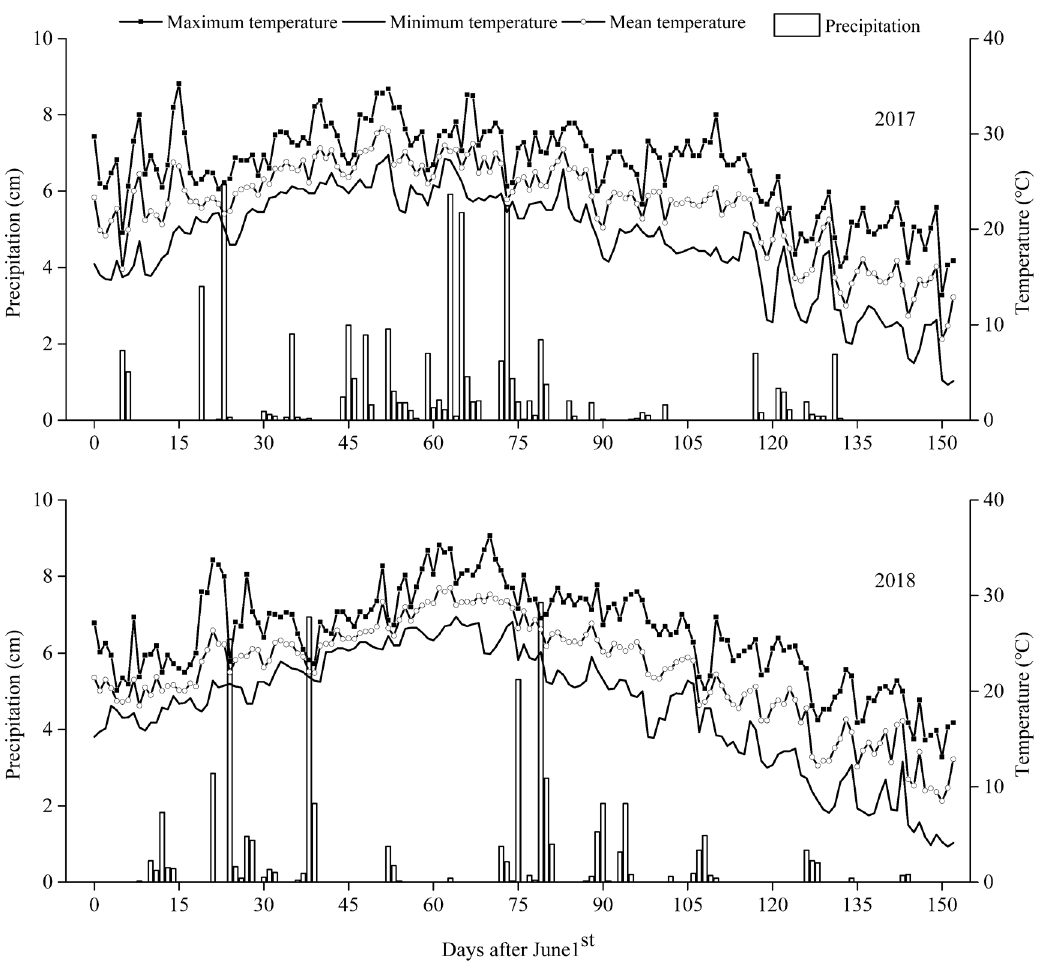
Figure 3. Precipitation (cm), maximum temperature, minimum temperature, mean temperature ( ℃ ) recorded during the growing seasons (from June 1st to October 30th) in 2017 and